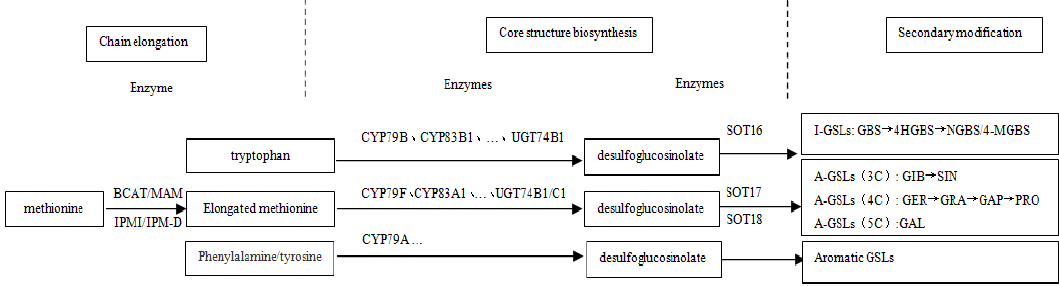
Figure 1. Schematic diagram of the glucosinolate biosynthesis pathway of Cruciferae plants [23,38].